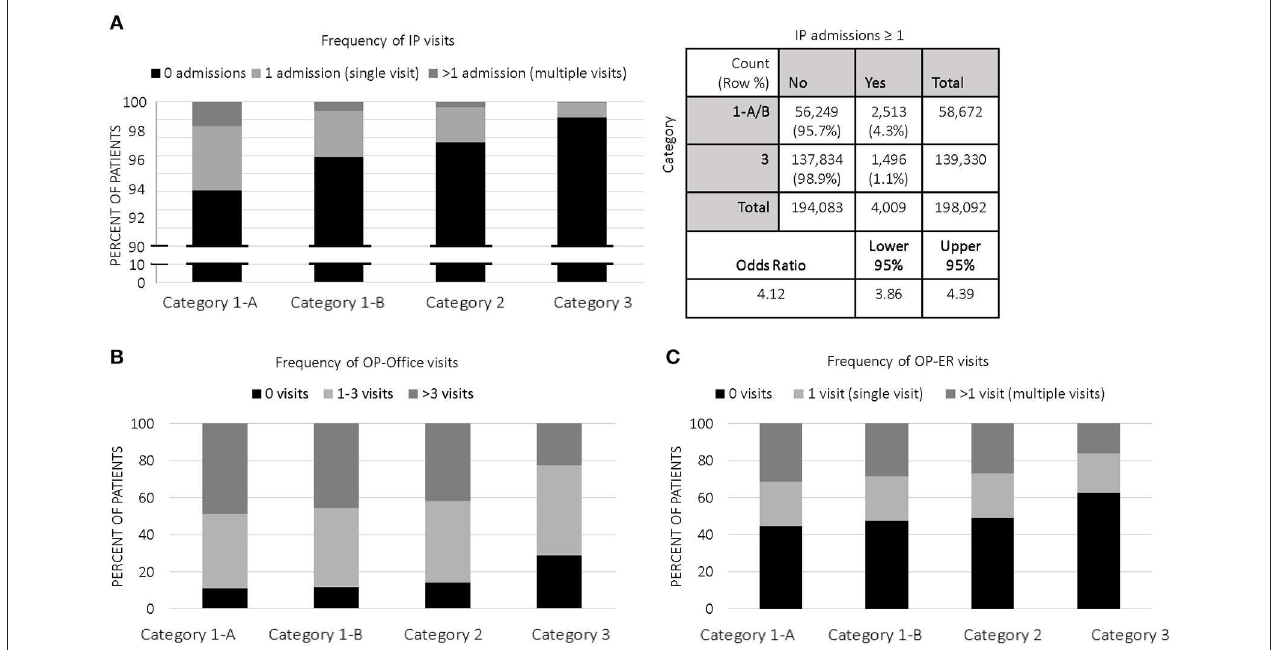
FIGURE 2 | Categorical Distribution of Visits: (A) Frequency of IP visits among categories in 2014; 2 × 2 contingency table with odds ratio of category 1 (A&B, genetic) vs. category 3 (non-genetic); (B) Frequency of OP-office visits among categories in 2014; (C) Frequency of OP-ER visits among categories in 2014.